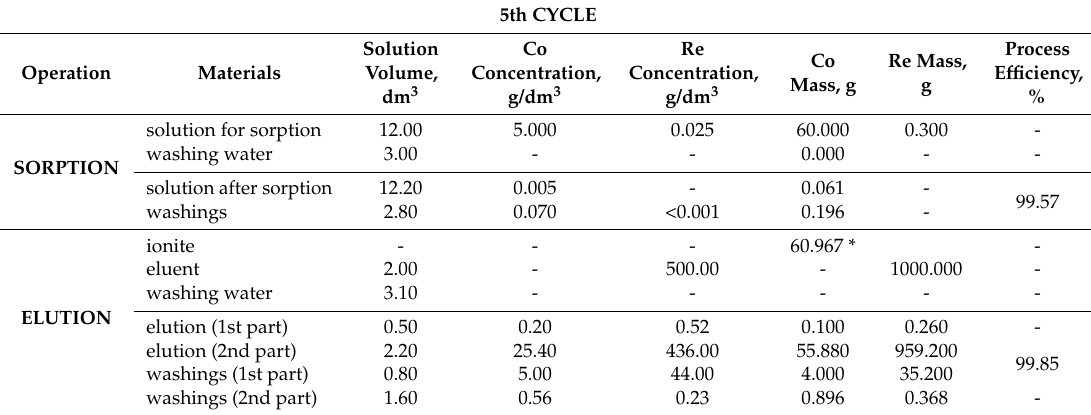
Table 12. Balance for cobalt(II) sorption and elution—5th cycle. 5th CYCLE